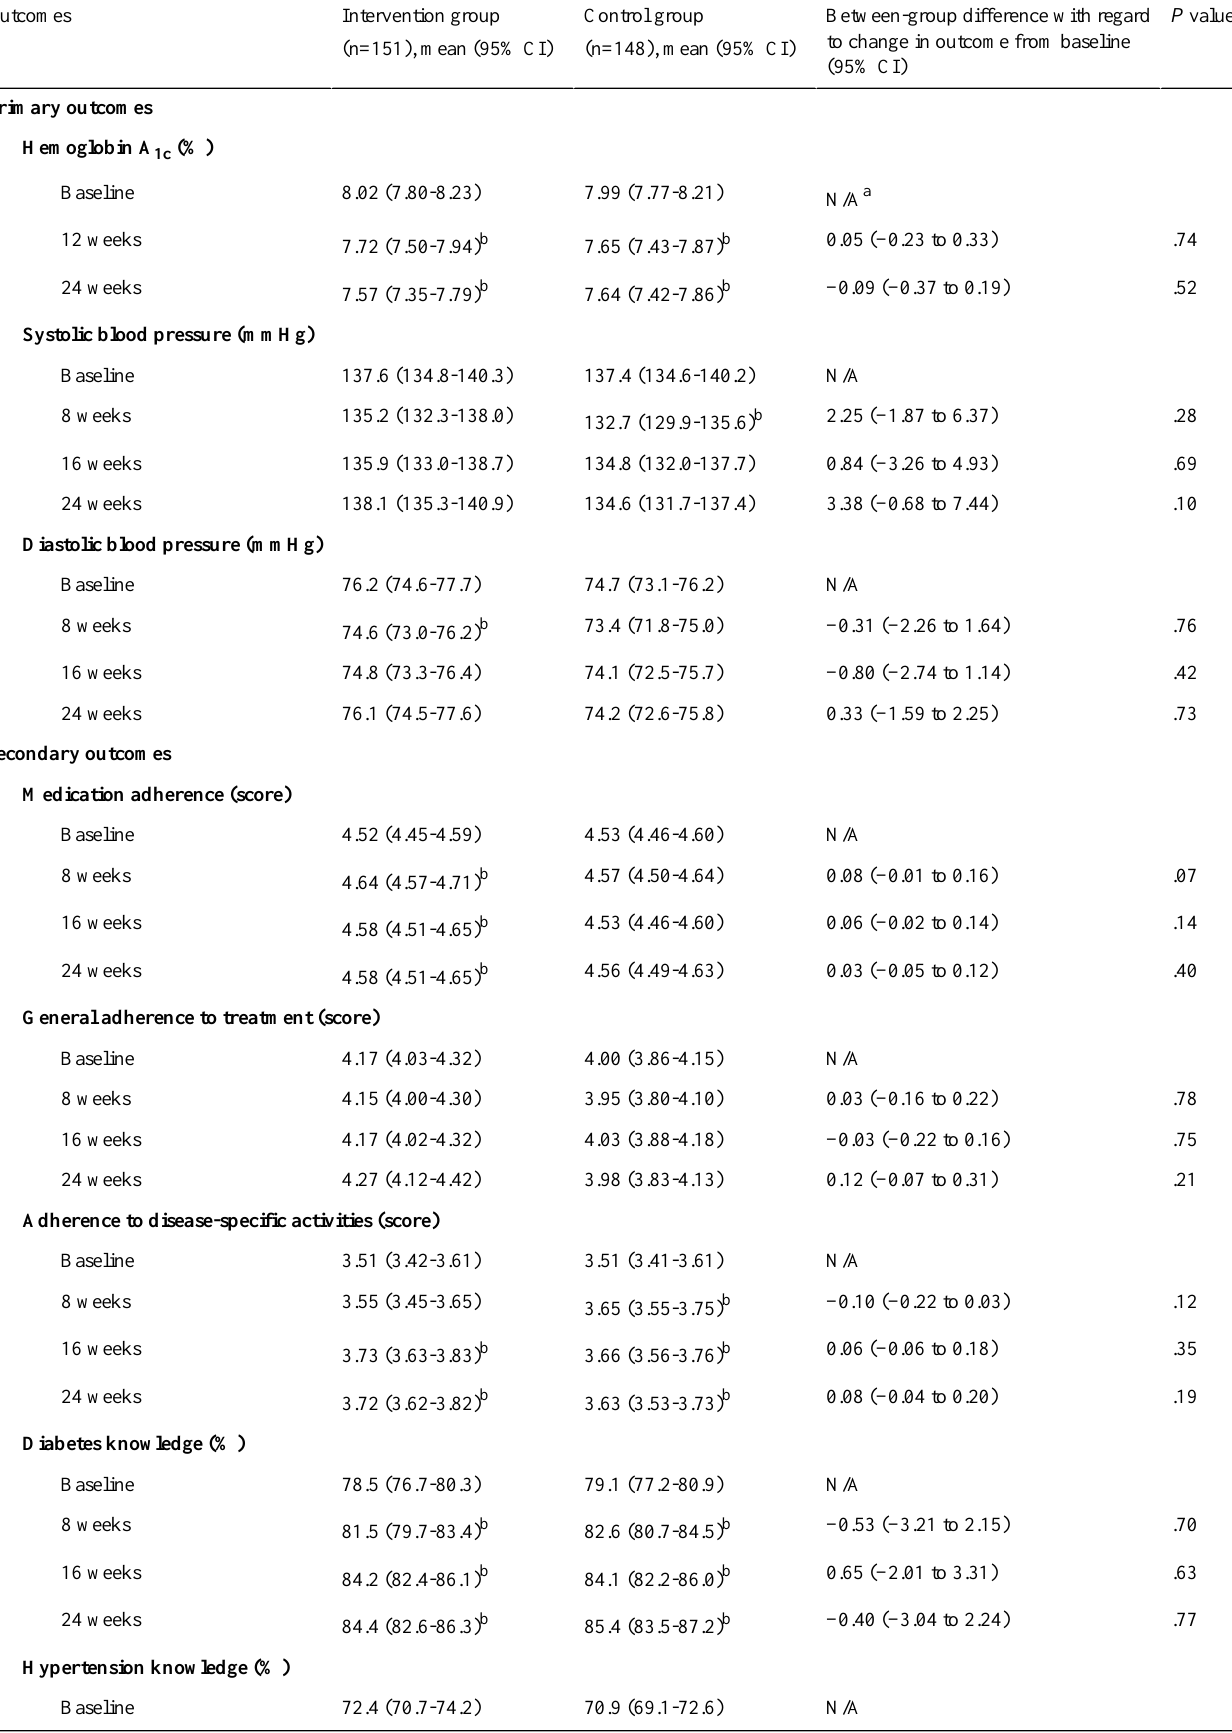
Table 2. Results of intention-to-treat analysis.